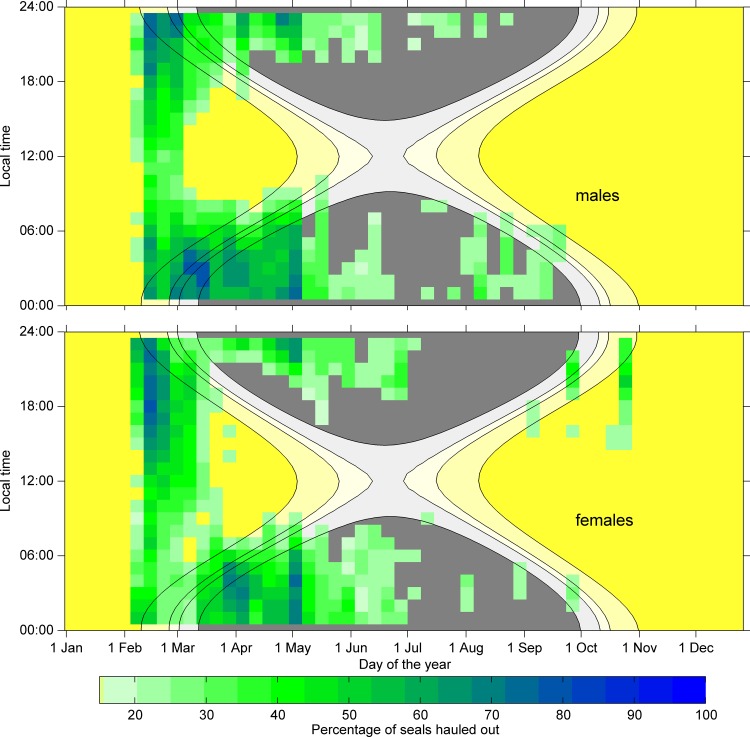
Density plot of percentage of seals hauled out within the specific hour.Densities for males (top) and females (bottom) of less than 20% are not shown. Background colours show the sun angle for an observer at latitude of 74.5°S with contour lines for astronomical twilight (-12°), nautical twilight (-8°), civil twilight (-6°) and sun rise/set (-0.8°). Night time (sun angle below -8°) is grey, while day time (sun angle above -8°) is yellow.